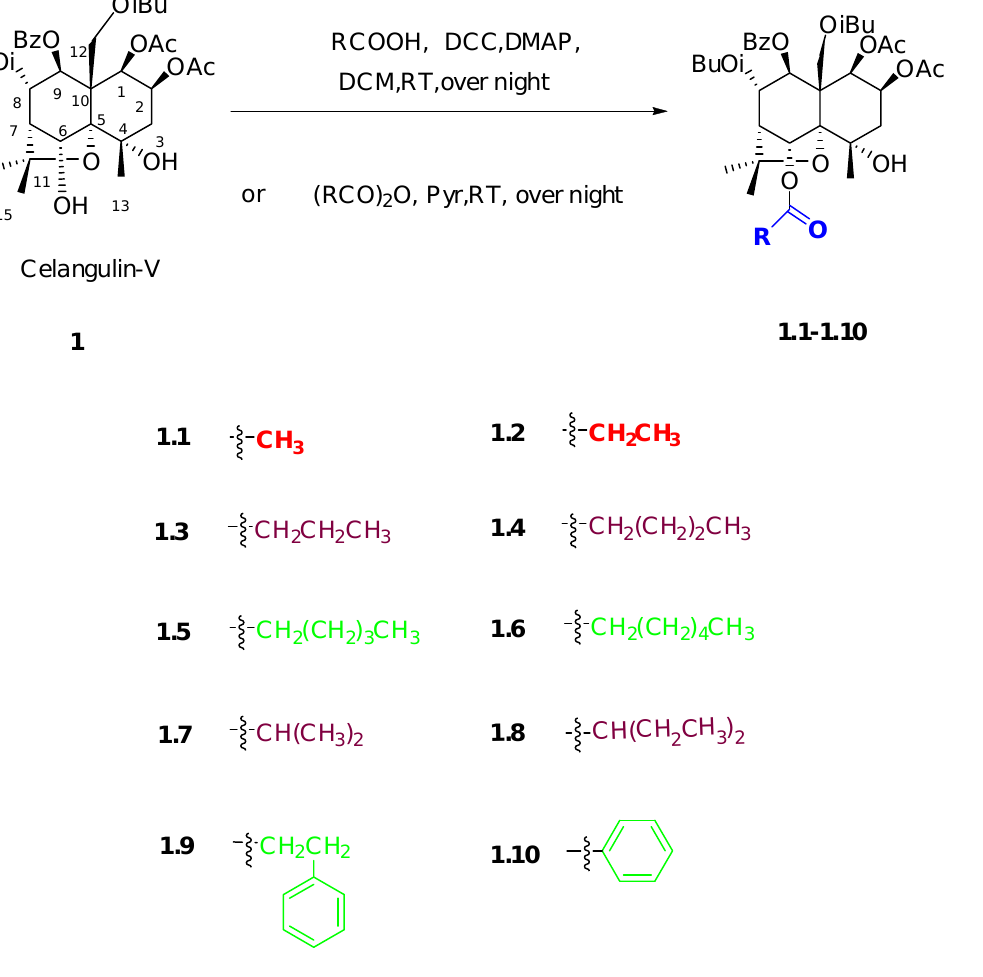
Table 1. Experimental Data of Celangulin-V and its